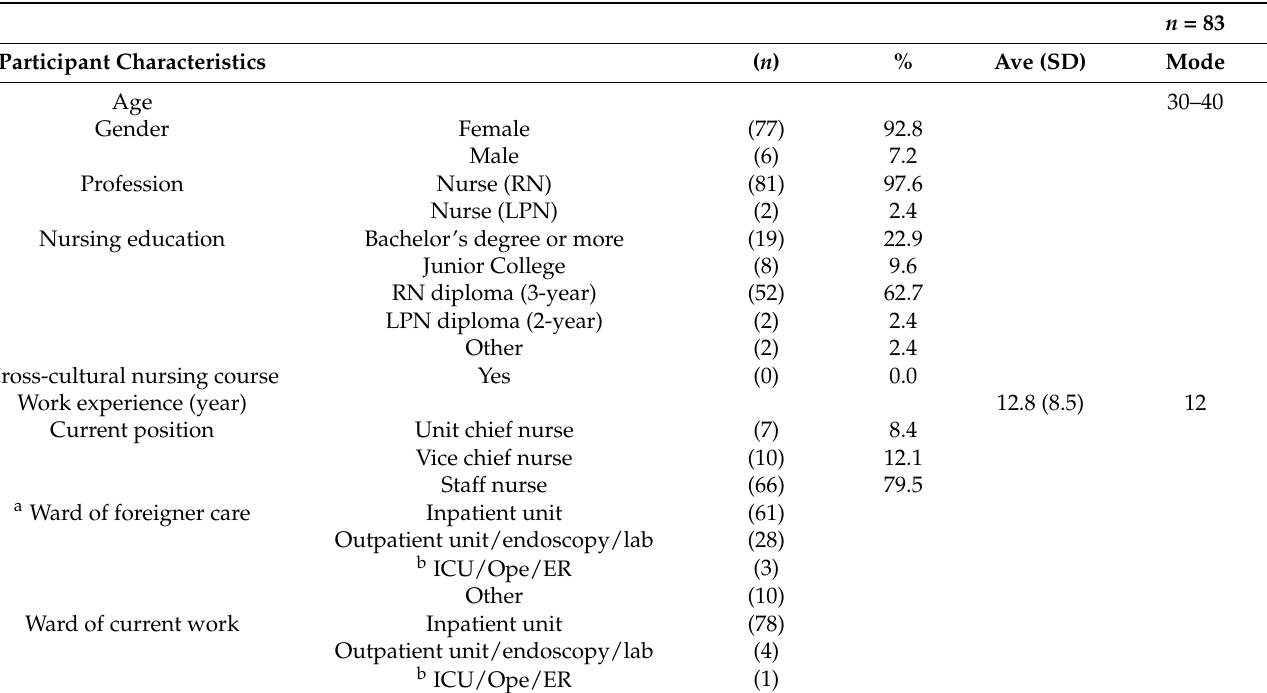
Table 1. Demographic profiles of